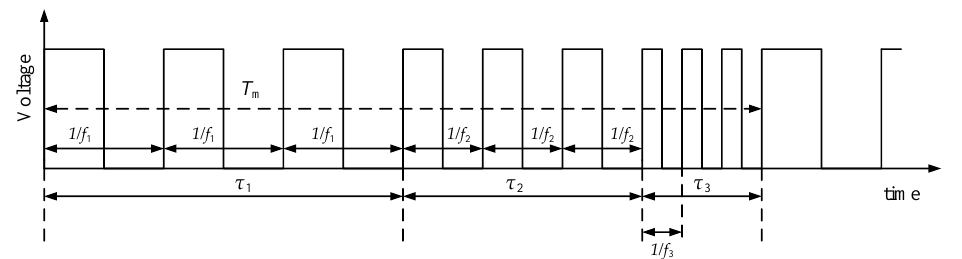
Figure 3. Waveform of a square signal with 3F technique [7]. During τ 1 the system operates at frequency f 1 , during τ 2 the system operates at frequency f 2 , and during τ 3 the system operates at frequency f 3 .